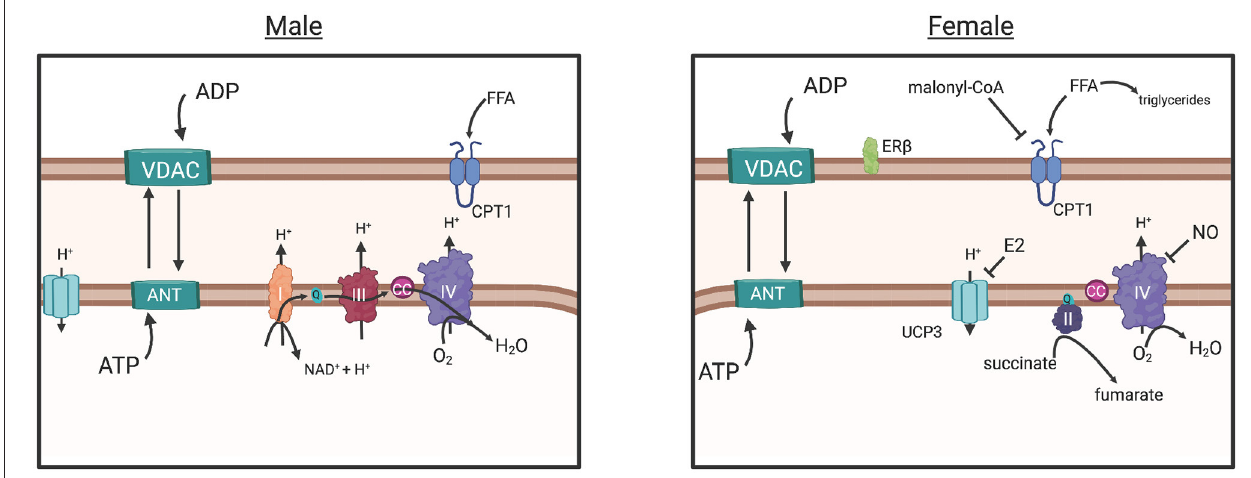
FIGURE 4 | The commonly understood electron transport chain, simplified (male), results in ROS buildup, a consequence of increased O2 diffusion into the mitochondria and subsequent consumption by CIV, greater ADP influx (due to greater ADP sensitivity) and ATP production. The parallel pathway (female) is depicted, however the degree in which it functions over or in conjunction with the common pathway (male) is not fully understood. Briefly: Decreased O2 consumption in peripheral tissues may have induced adaptation of mitochondria in females to require more efficient control of energy production, as evidenced by human and animal studies (in text). Decreased ADP sensitivity (sex differences in VDAC and ANT regulation unknown) in females would prevent large influx of ADP from the cytosol, reducing the production of ROS overall. Estrogen represses Ucp3 expression, preventing energy dissipation, and reduces proton transport into the mitochondria, a possible strategy for energy conservation and a response to decreased ROS production. Increased Malonyl-CoA production, inhibits CPT1 transport of free fatty acids into the mitochondria, resulting in greater triglyceride production in the cytosol and a more controlled energy production within the mitochondria. Greater CII involvement (female), requiring less proton influx may control production of ROS further. Overall, these adaptations suggest that females exhibit an efficient control of ATP production while simultaneously reducing ROS production. Created with BioRender.com. ADP, adenosine diphosphate; ATP, adenosine triphosphate; ANT, adenosine nucleotide translocase; VDAC, voltage-dependent anion channel; CC, cytochrome c; UCP3, uncoupling protein 3; CPT1, carnitine palmitoyltransferase; Complex I, II, II, IV; E2, estradiol; FFA, free fatty acid; ER-beta, estrogen receptor beta; NAD + , nicotinamide adenine dinucleotide; ROS, reactive oxygen species; Q, coenzyme Q; H + ,